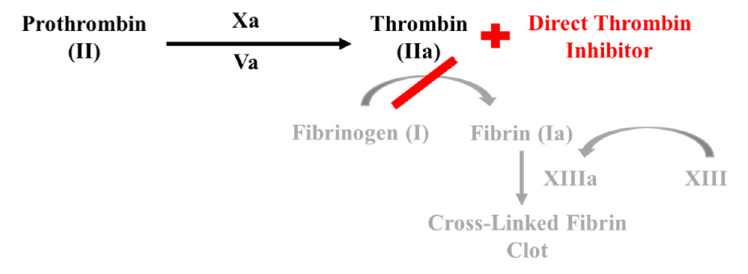
Figure 4. Mechanism of action for direct thrombin inhibitor.